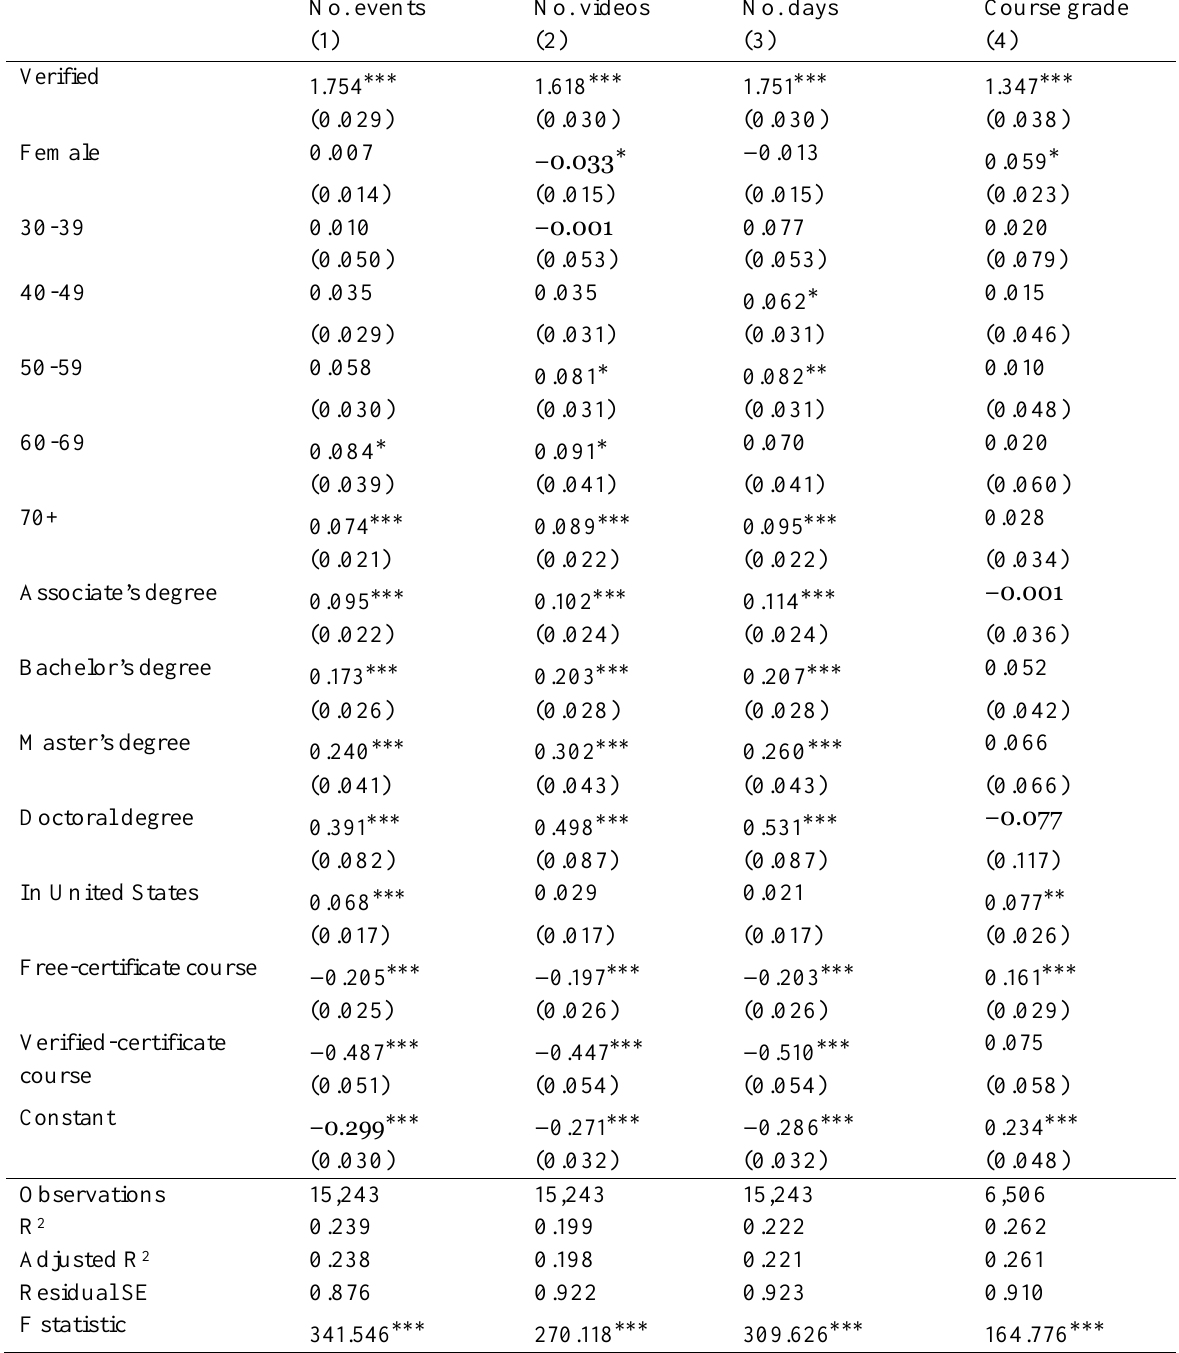
Regression Results for Case Study